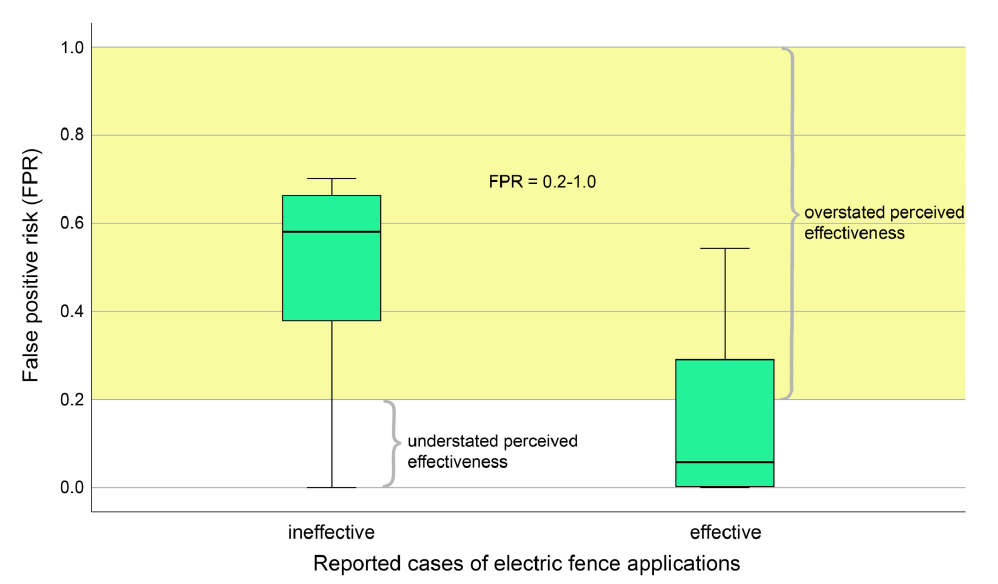
Fig 1. Distribution of false positive risk (FPR) in reported effective and ineffective cases of electric fence applications. The shaded area demarcates the area above the threshold of FPR = 0.2 where cases are statistically proven to be ineffective. The ranges of FPR for overstated (reported as effective, but actually not as FPR � 0.2) and understated (reported as ineffective, but actually effective as FPR < 0.2) perceived effectiveness are shown. The lower is the threshold FPR (0.1 and 0.05 in this study), the wider is the range of overstated perceived effectiveness and the narrower is the range of understated perceived effectiveness.